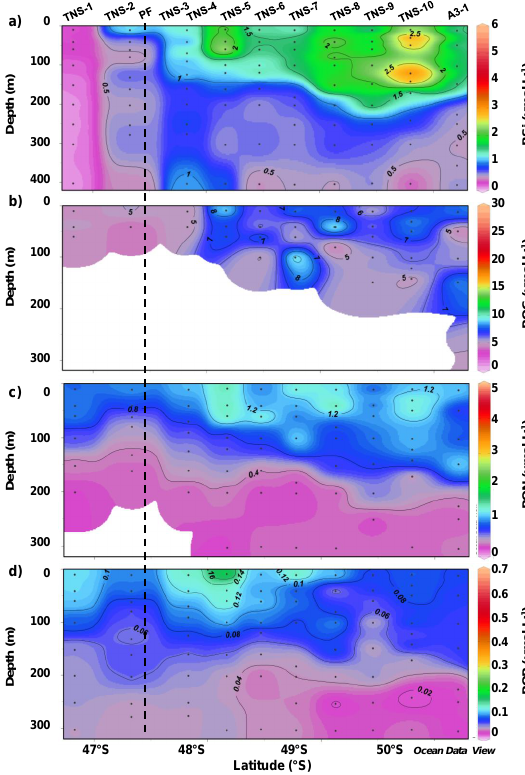
Figure 10. Figure 10. Vertical distributions of BSi (a) , POC (b) , PON (c) , POP (d) concentrations along the TEW transect. The dashed lines repre- sent the approximate location of the southern branch of the polar front going to the north (NPF) and to the south